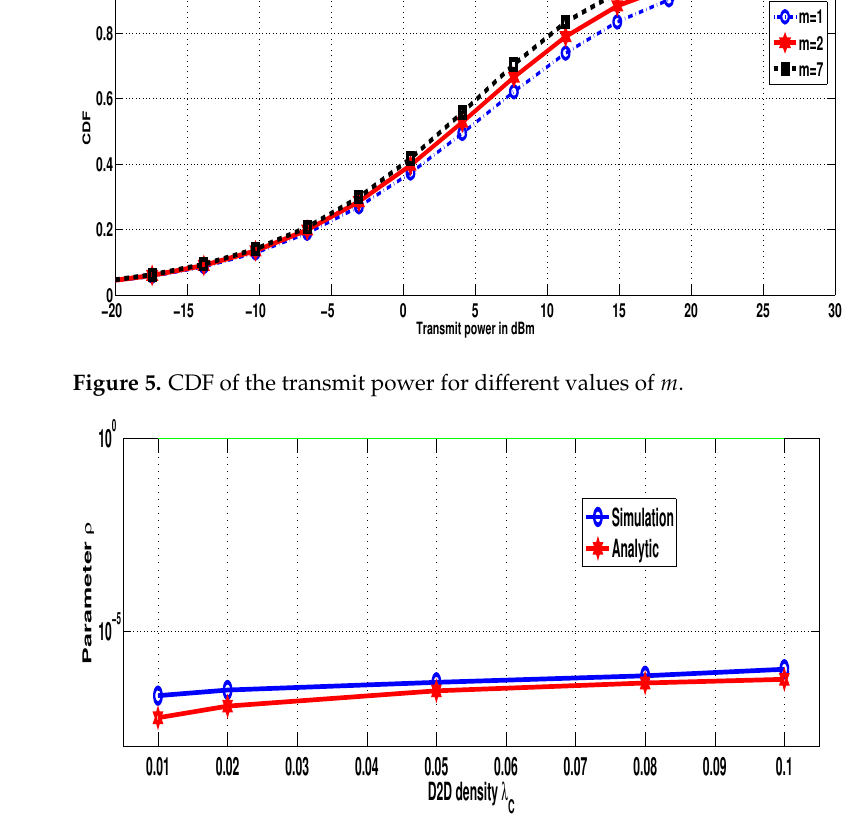
Figure 6. D2D user transmission probability ρ vs. λ C